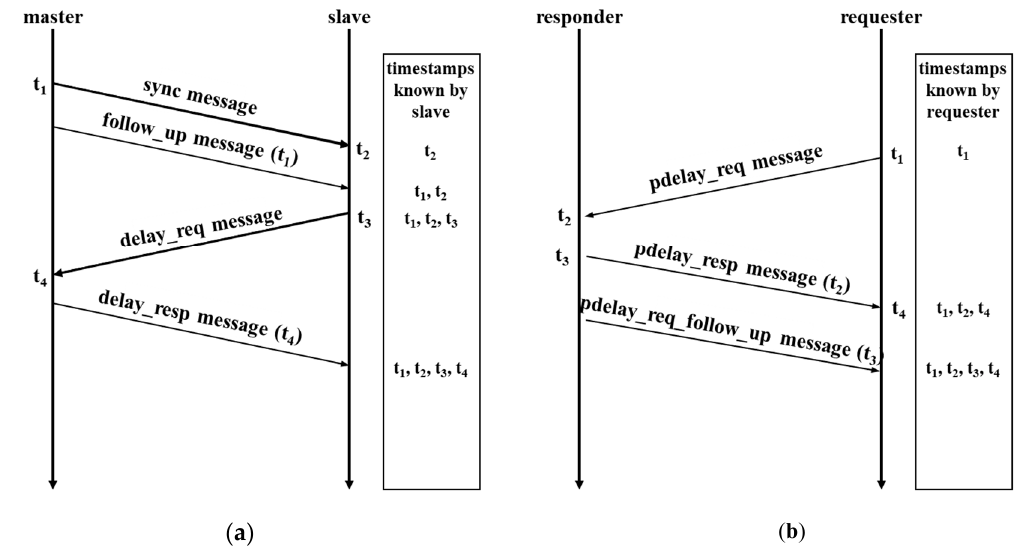
Figure 1. Time-synchronization mechanism of IEEE 1588 in ( a ) end-to-end and ( b ) peer-to-peer systems [13].